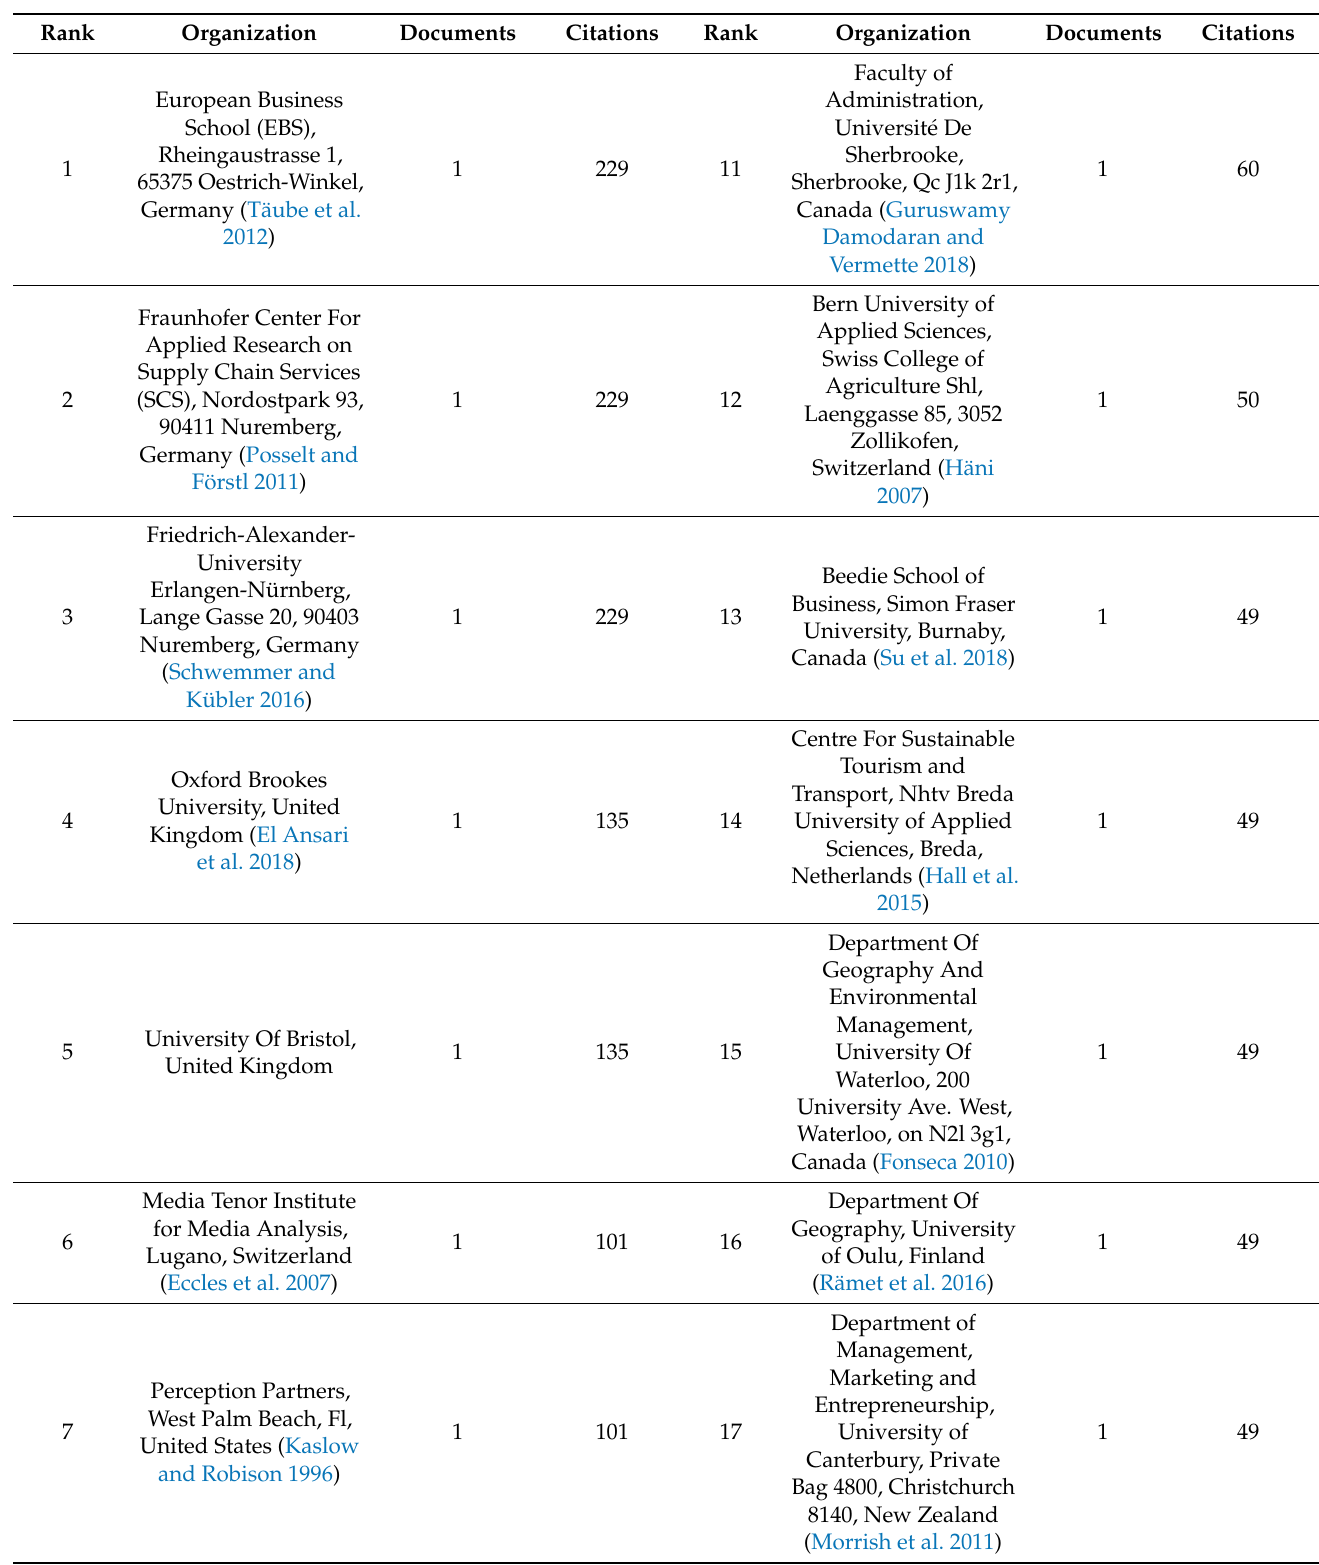
Table 4. Organizations regarding